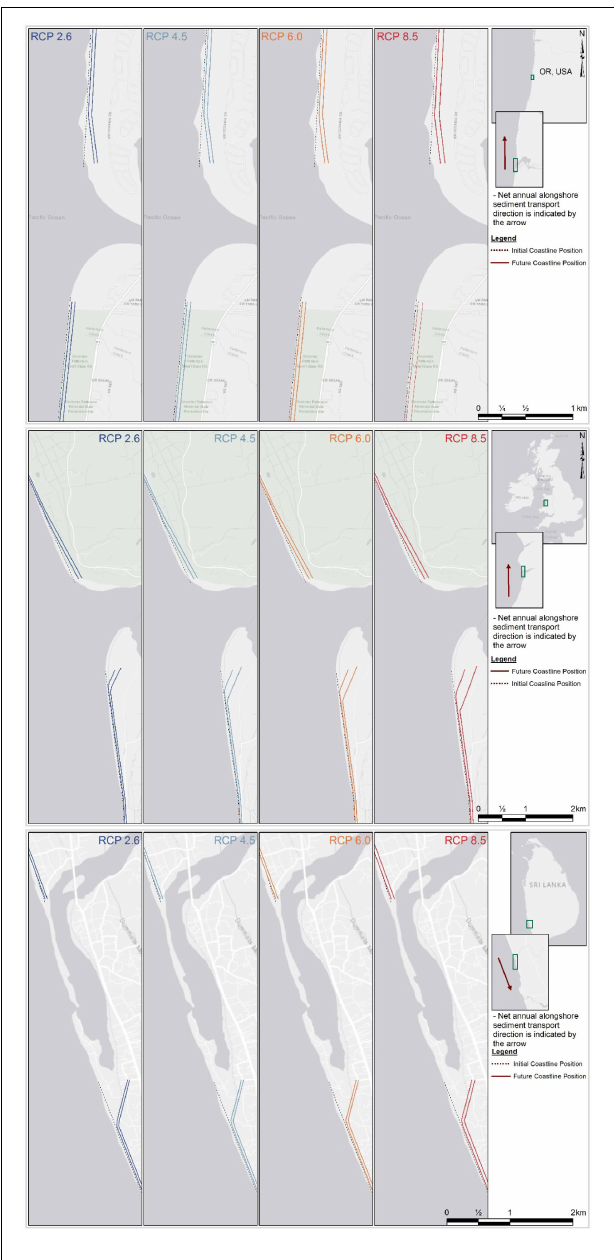
FIGURE 12 | Projected changes of the inlet-affected coastline at the Alsea estuary (top) , Dyfi estuary (middle) , and Kalutara estuary (bottom) . The two solid lines in each subplot represent the final coastline position by 2060 and 2100 (in the same order, moving landward from the most seaward line). The dotted line in each subplot represents the initial (reference) coastline